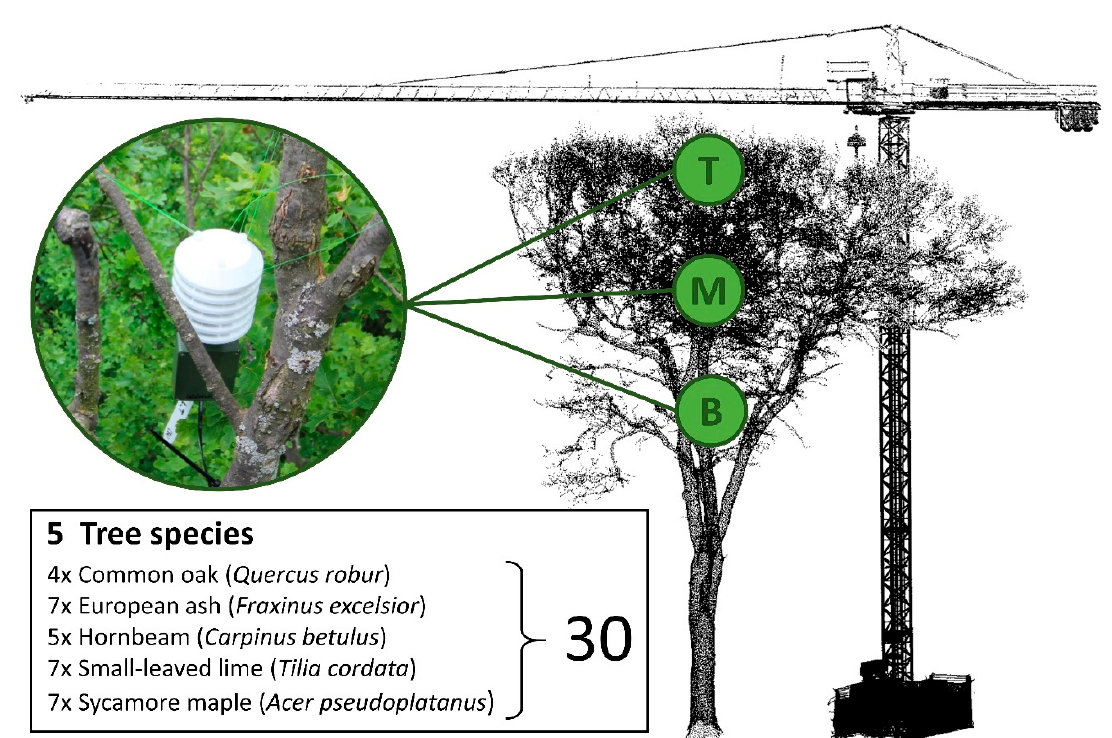
Figure 2. Schematic representation of the sensor setup for measuring air temperature at three different heights in tree crowns (T = top position, M = middle position, and B = bottom position) at the Leipzig Canopy Crane facility.